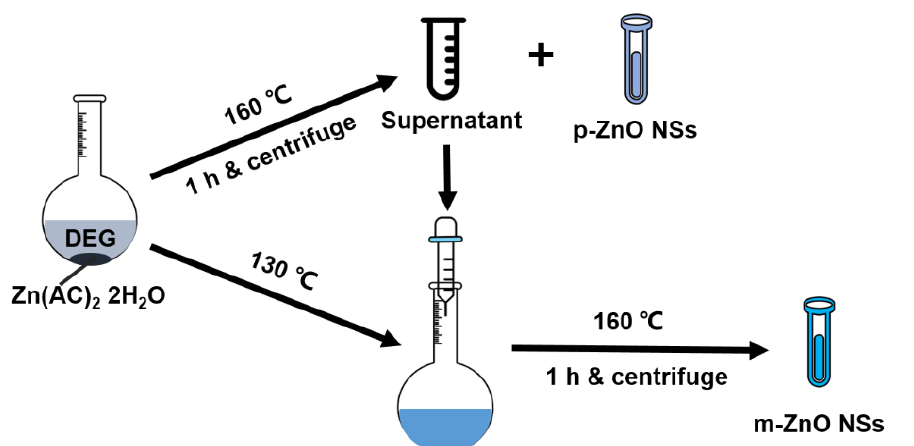
Figure 1. Schematic diagram for the fabrication process of p-ZnO NSs and m-ZnO NSs by the pyrolysis method.